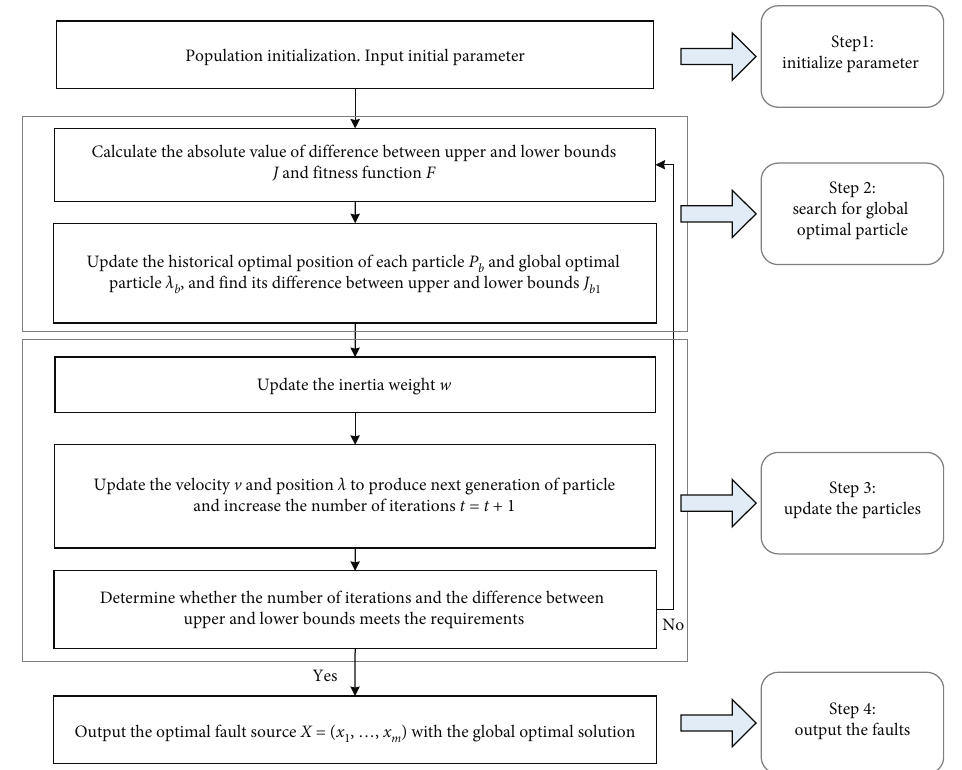
Figure 1: The flow chart of the Lagrange-particle swarm optimization